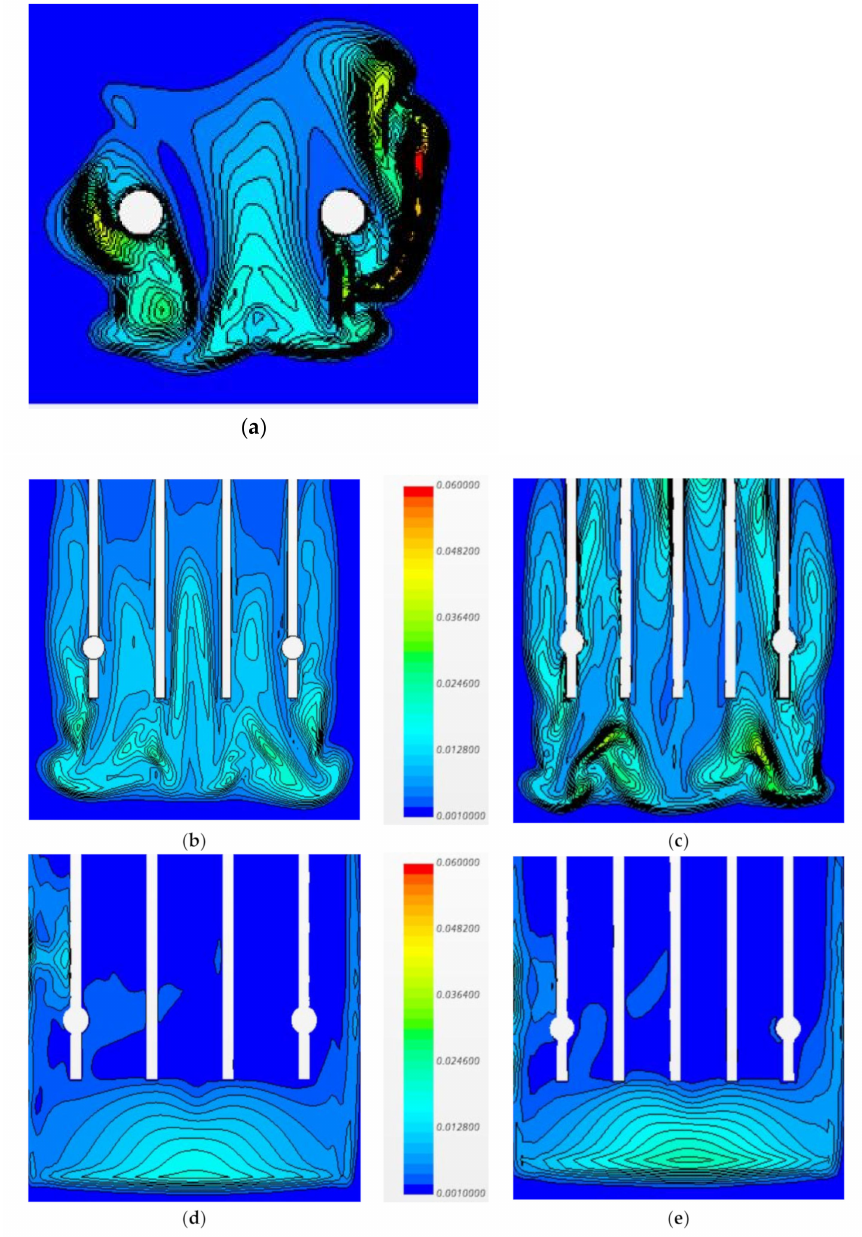
Figure 10. Turbulence intensity on the YZ plane at x = 0.026 m: ( a ) baseline case; ( b ) Case 1; ( c ) Case 2; ( d ) Case 3; ( e ) Case